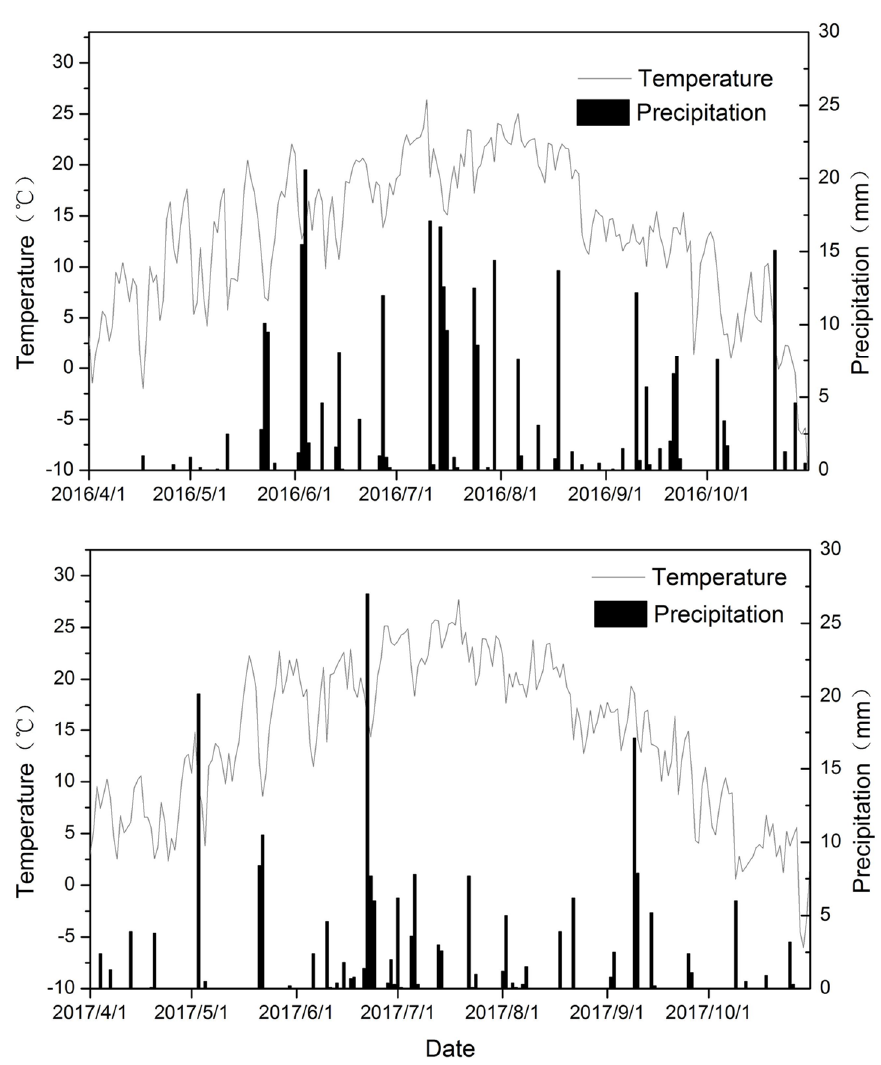
Figure 3. Precipitation and temperature during growing season in different precipitation years.